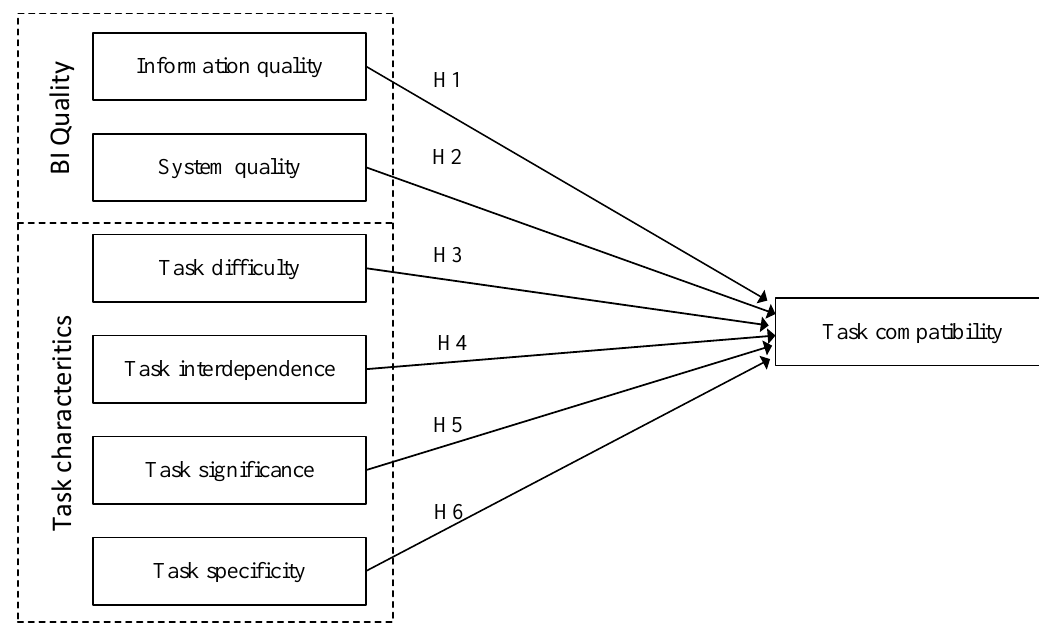
Figure 1 . Task/BI Compatibility